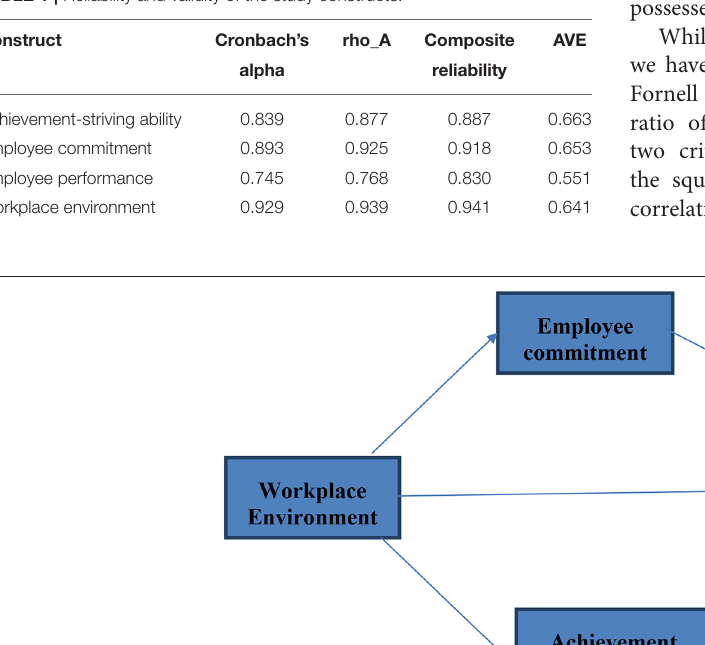
TABLE 1 | Reliability and validity of the study constructs.